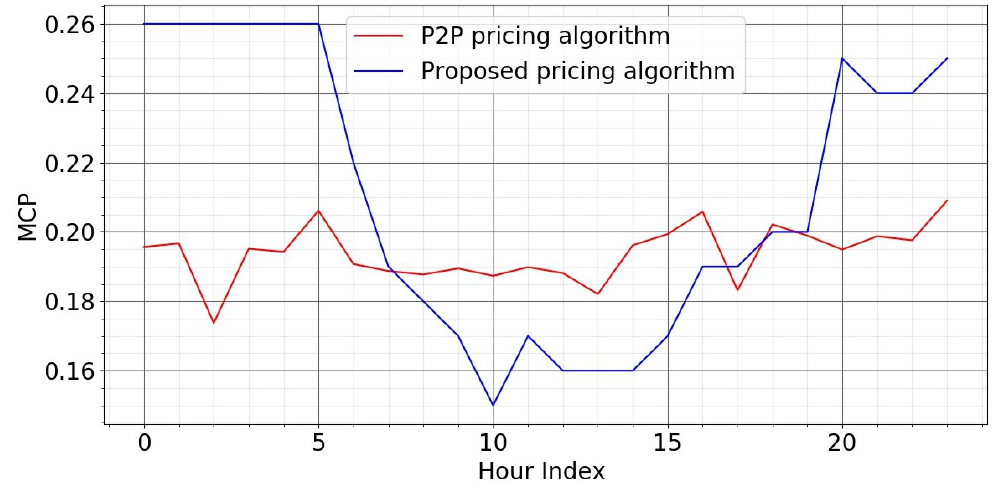
Figure 7. Hourly prices with the two (2) different pricing